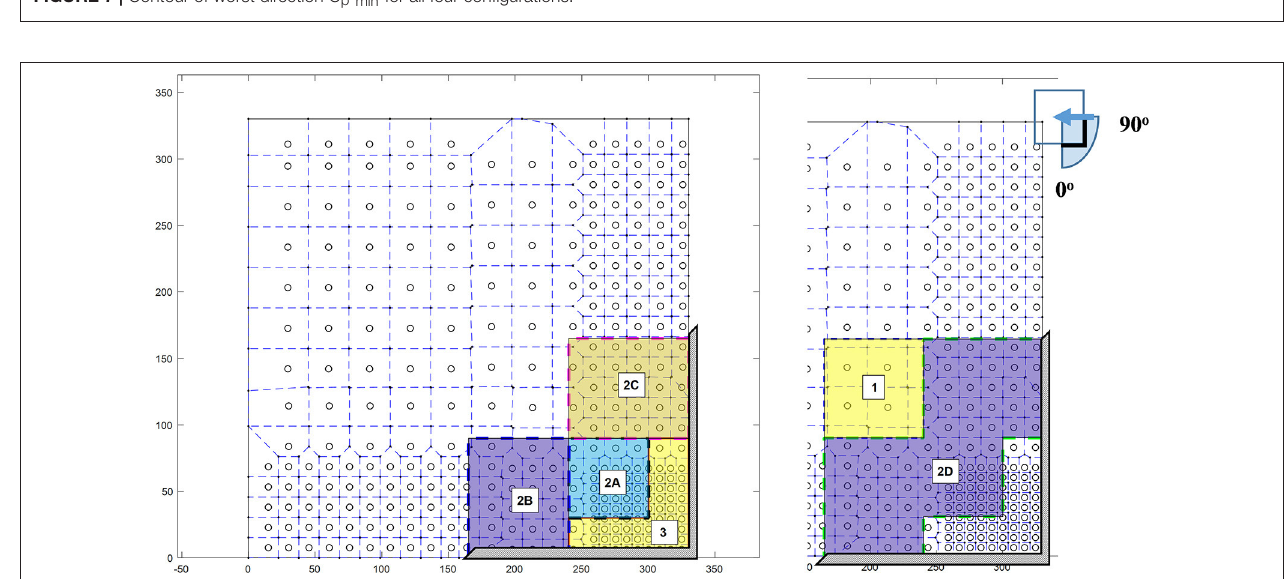
FIGURE 8 | Location of the area averaging zones and the mitigation device.